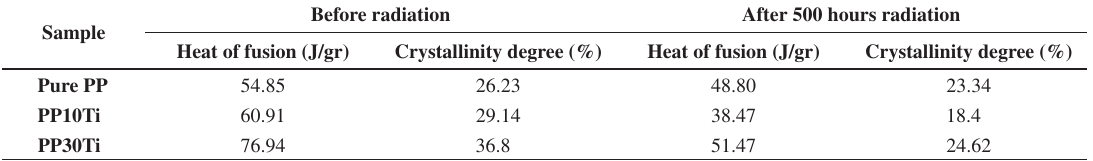
Table 2. Variation of crystallinity degree and heat of fusion of pure PP and PP Nano-composites with radiation time.